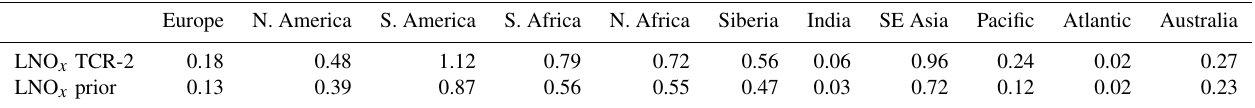
Table 9. Same as in Table 7 but for lightning NO x sources NO x (in TgNyr − 1 ) for North America (20–60 ◦ N, 120–65 ◦ W), Europe